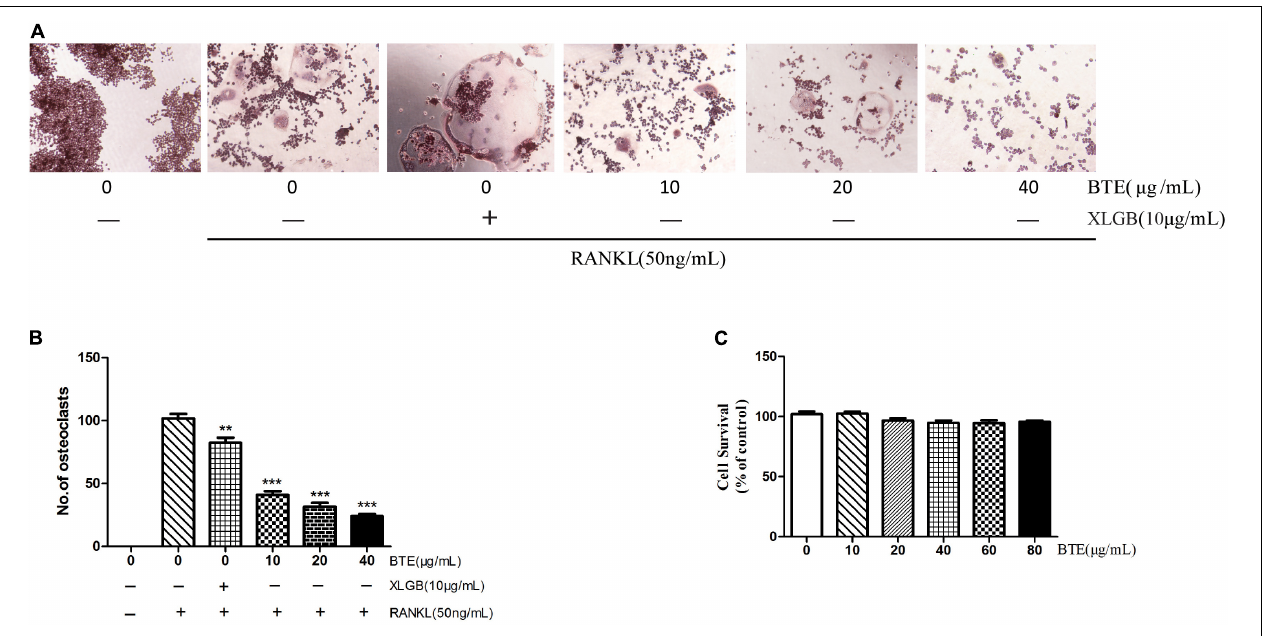
FIGURE 4 | The effect of black tea extract (BTE) on osteoclastogenesis. (A) The role of BTE in the differentiation of RAW264.7 cells into osteoclasts was determined by tartrate-resistant acid phosphatase (TRAP) staining (magnification × 200). (B) The TRAP staining results were analyzed, where TRAP-positive multinucleated cells containing five or more nuclei were counted as osteoclasts. (C) The survival of RAW264.7 cells in the presence of various concentrations of BTE was determined using the MTT assay. All data are presented as mean ± SEM ( n = 3). “One way ANOVA” was used for the comparison of BTE treatment vs only RANKL treatment. ∗∗ p < 0.01and ∗∗∗ p < 0.001 vs only RANKL